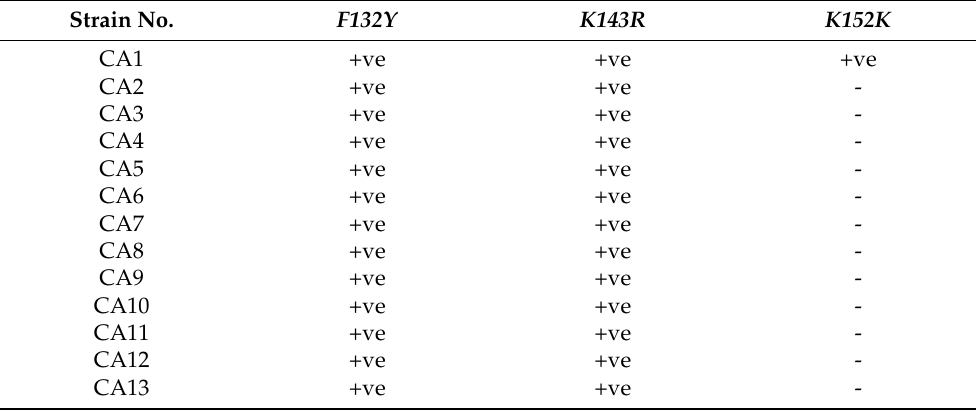
Figure 1. Representative of the phylogenetic analysis of the Candida auris isolates. The isolate CA18 from the Candida auris isolates analyzed using the 18S rRNA sequence by maximum likelihood method and phylogenetic tree constructed using MEGA7. The yellow highlight indicates the C. auris CA18. Table 1. List of variants identified in the lanosterol 14-alpha demethylase (ERG11) gene of Candida au- ris